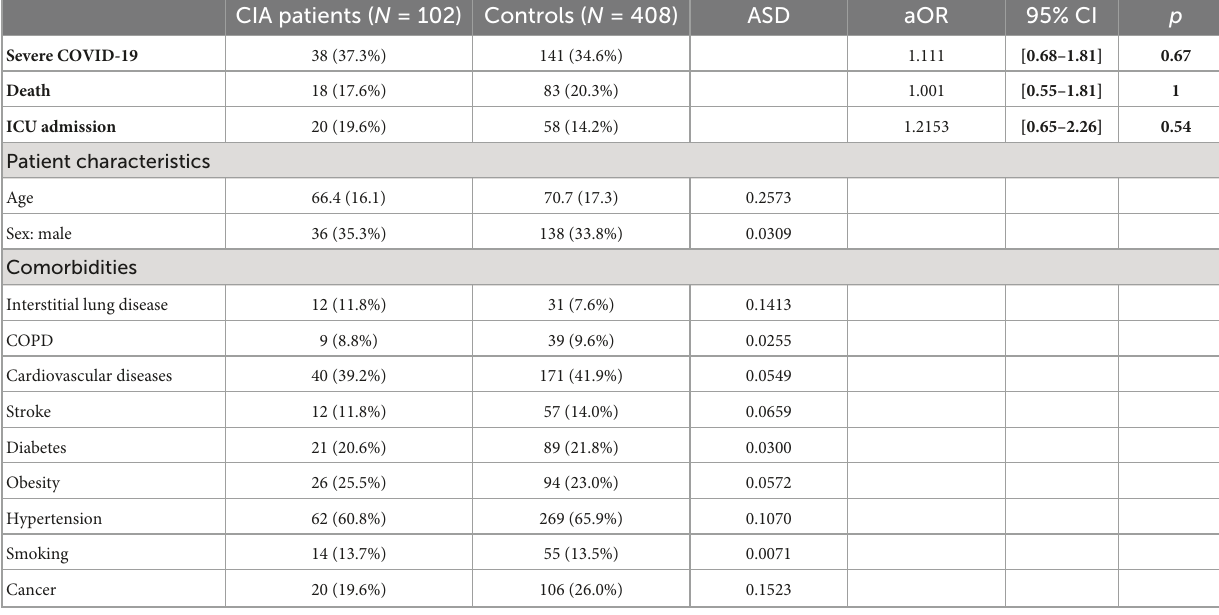
TABLE 5 Odds of severe COVID-19: Comparison between patients with or without chronic inflammatory arthritis–case control study within EDS database. CIA patients ( N = 102) Controls ( N =